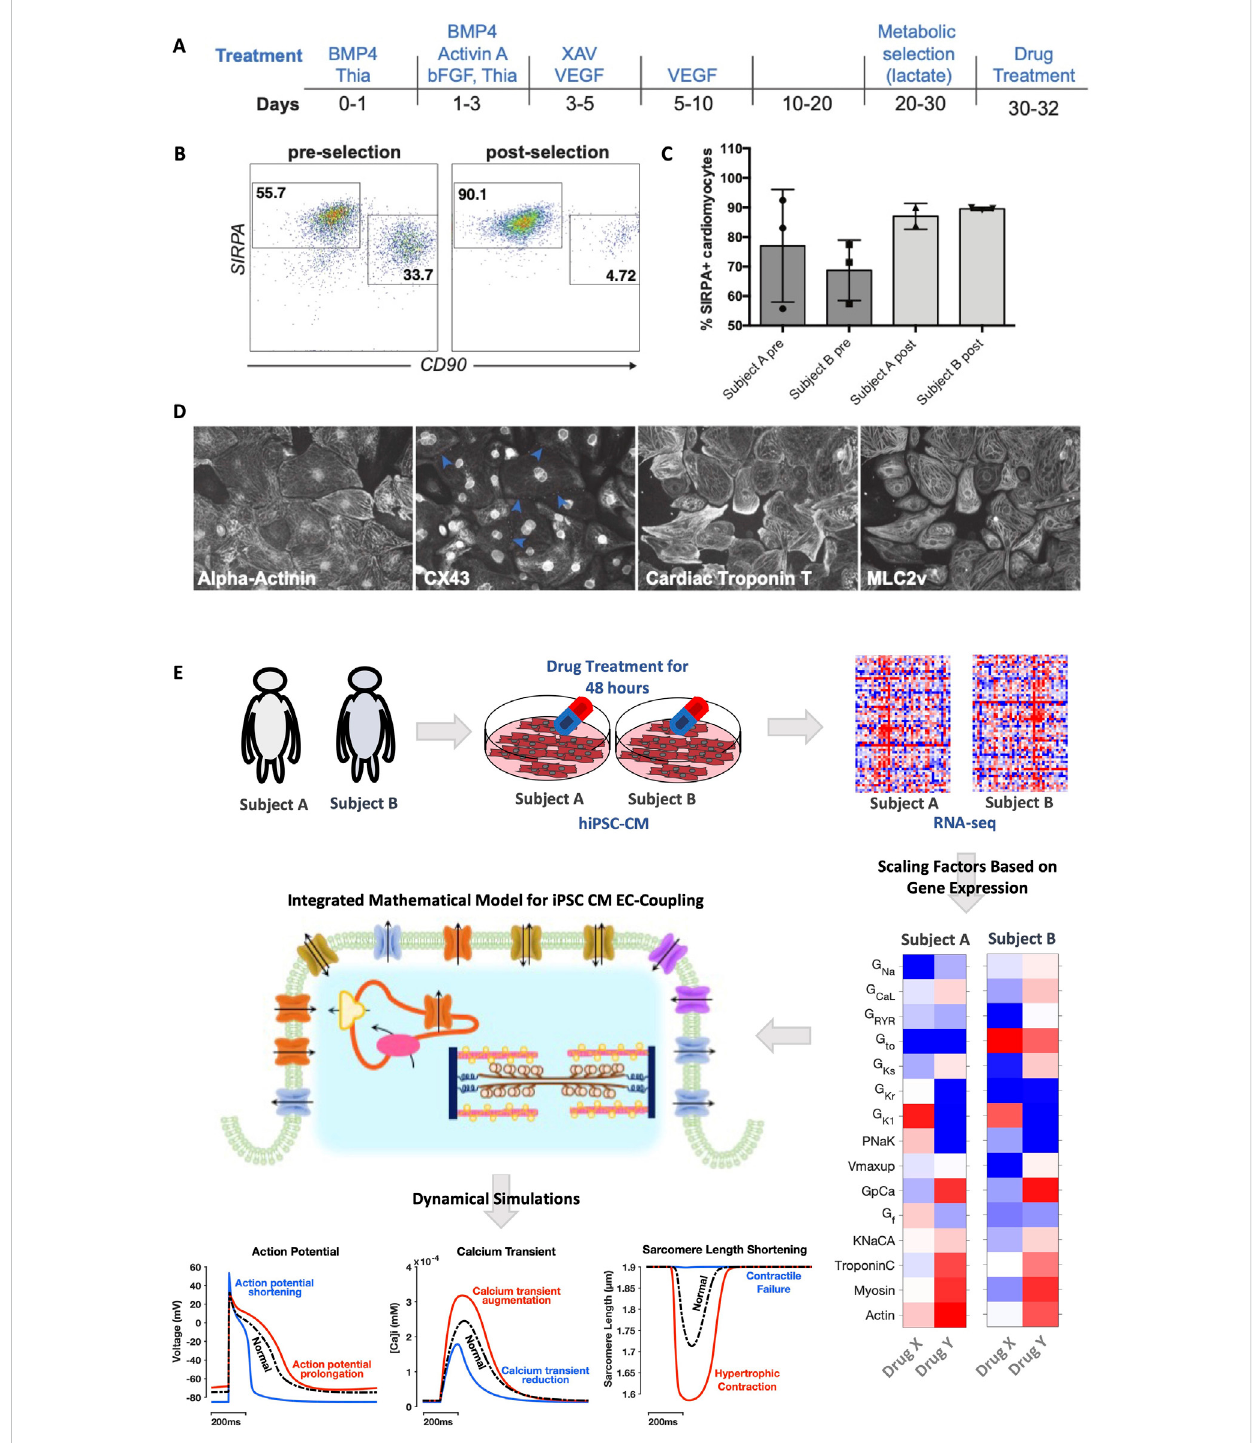
FIGURE 1 Preparation of puri fi ed iPSC-CMs and computational pipeline for simulation analysis. (A) Schematic of differentiation and metabolic selection of human pluripotent stem cells. (B) Flow cytometry analysis for SIRPA (cardiomyocyte marker) and CD90 ( fi broblast marker) at day 20 (before lactate selection) and day 30 (after lactate selection). (C) Quanti fi cation of SIRPA + cells before and after lactate selection in the two cell lines, based on n = 3 differentiations in each cell line. (D) IF analysis of iPSC-CMs after lactate selection at day 30, Cells were stained with antibodies against α -actinin, Connexin 43 (CX43), cardiac Troponin T and MLC2v. (E) Study work fl ow illustrates how iPSCs derived from two healthy human volunteers were differentiated into cardiac myocytes, then treated with 26 FDA-approved tyrosine kinase inhibitor drugs. Gene expression was quanti fi ed in each cell line with mRNA-seq, and genes relevant to iPSC-CM excitation-contraction coupling were extracted and converted into fold changes, indicating relative changesresultingfromdrugtreatment.Thesefoldchangescorrespondedtoalterationsinmathematicalmodelparameters,speci fi ctoeachcellline,and simulations predicted changes in action potentials, intracellular Ca 2+ transients, and sarcomere shortening caused by